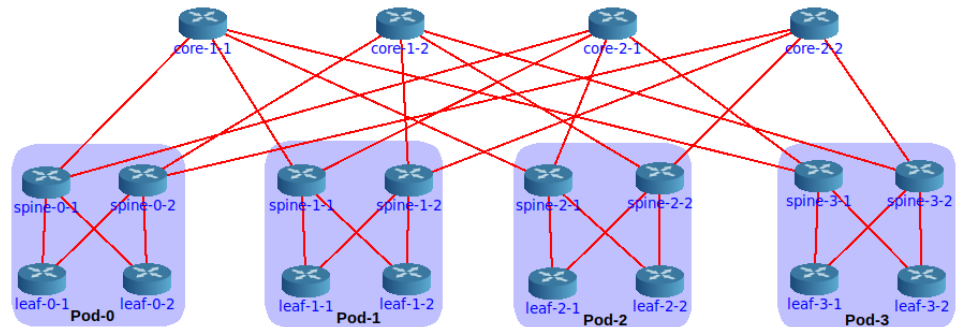
Figure 2. A fat-tree with k = 4 build in